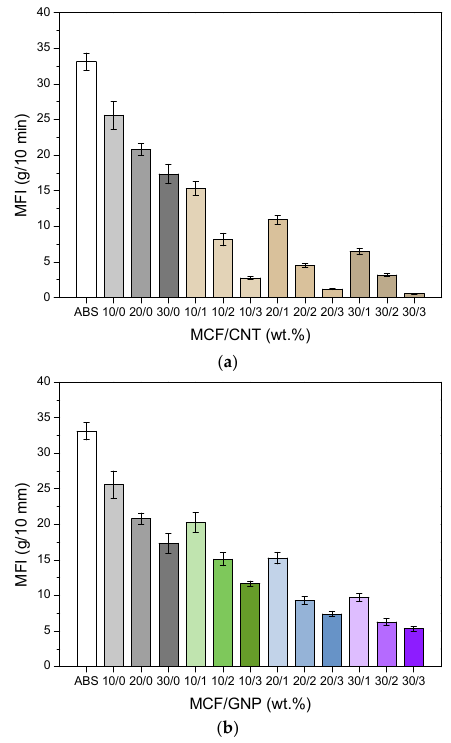
Figure 3. Melt flow index values (220 °C, 10 kg) of neat ABS and multiscale composites as a function of different ( a ) carbon nanotube and ( b ) graphene contents in MCF/CNT and MCF/GNP composites, respectively. The relative ratio of MCF vs. CNT or GNP is reported in percentage by wt. The average values are reported in Table S2 of the Supplementary Materials.